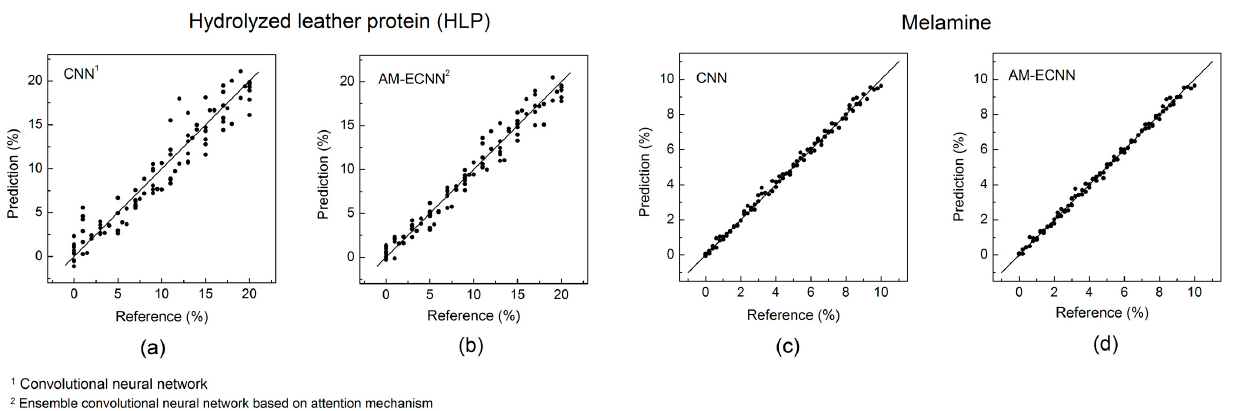
Figure 7. Regression plots obtained by the convolutional neural network (CNN) and the ensemble convolutional neural network based on attention mechanism (AM-ECNN) ( a ) CNN regression plot for the hydrolyzed leather protein (HLP) data set; ( b ) AM-ECNN regression plot for the HLP data set; ( c ) CNN regression plot for the melamine data set; ( d )AM-ECNN regression plot for the melamine data